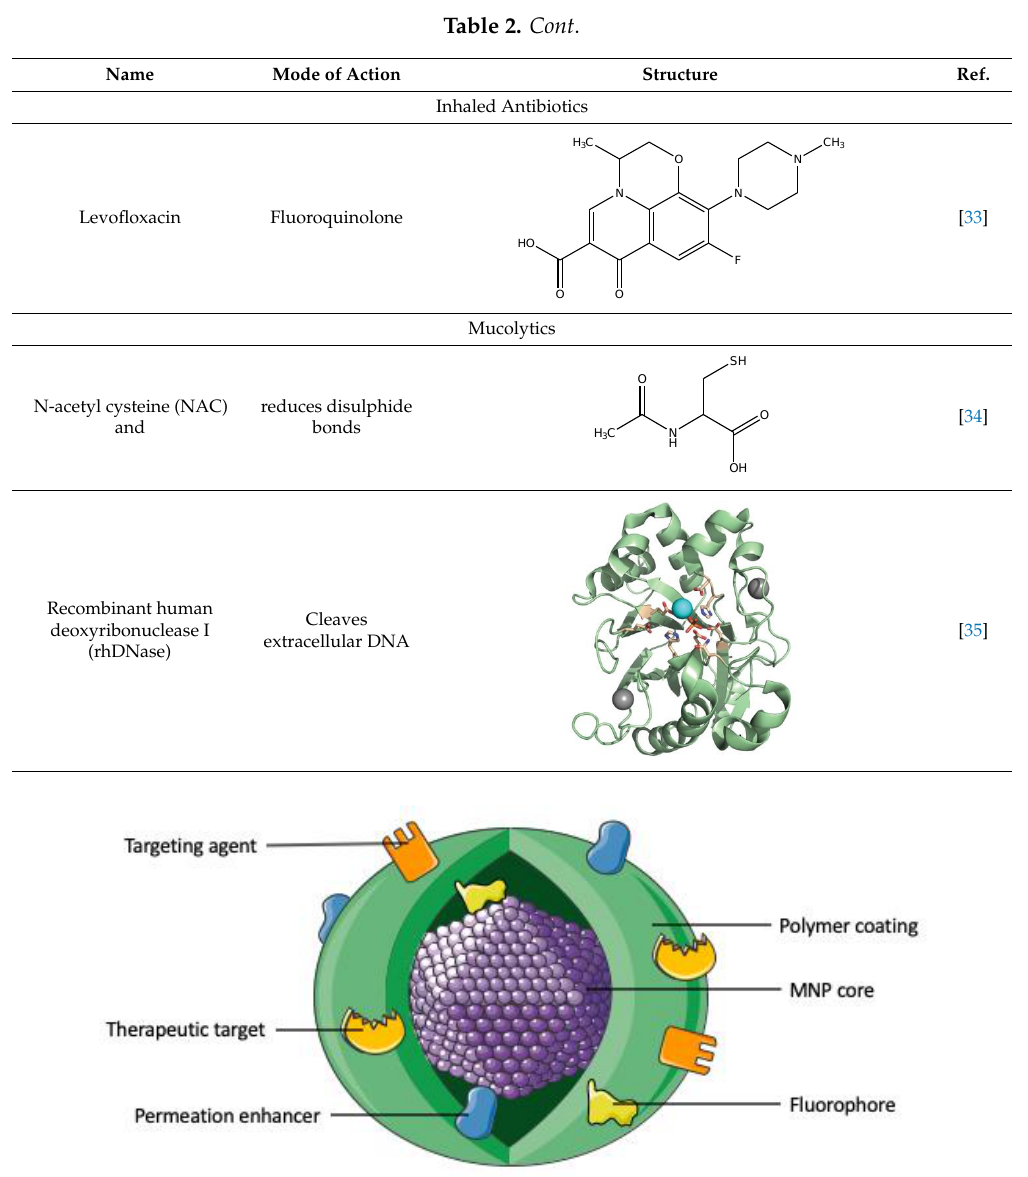
Figure 2. Magnetic nanoparticle coated with a surface coating and functional groups chosen for specific uses, e.g., targeting agents, permeation enhancers or